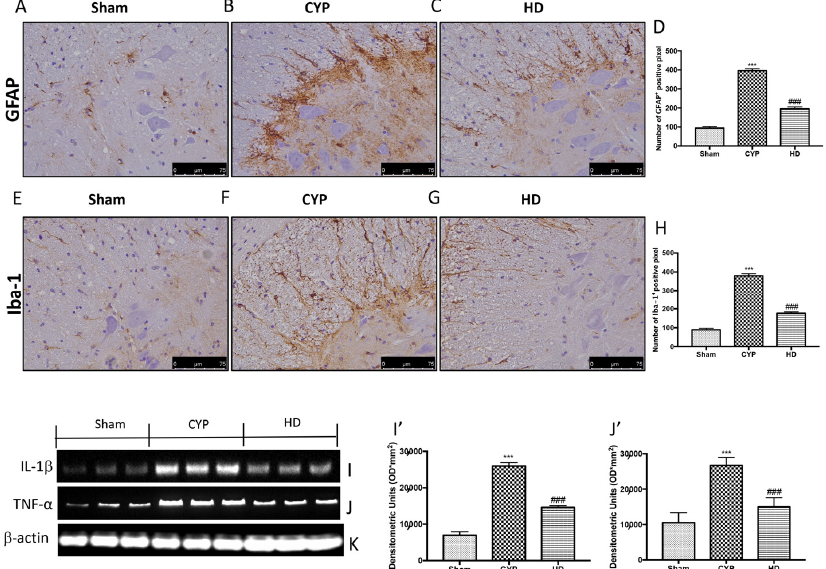
Figure 7. Effect of HD on neuroinflammation and on the release of proinflammatory cytokines in the spinal cord after repeated CYP injections. Immunohistochemical analysis showed a significant increase in glial fibrillary acidic protein (GFAP)-positive cells ( B , D ) and Iba-1-positive cells ( F , H ), compared to Sham mice ( A , D for GFAP and E , H for Iba-1). Mice treated with HD revealed a decrease in the expression of GFAP ( C , D ) and Iba-1 ( G , H ). Data are expressed as the number of GFAP- and Iba-1-positive pixels and are the means ± SEM of five animals for each group. Western blot analysis showed that IL-1 β expression was significantly increased in the CYP group, while treatment with HD decreased the expression of IL-1 β ( I , I’ ). TNF- α expression was significantly increased in the CYP group, while treatment with HD decreased the ex- pression of TNF- α ( J , J’ ). Protein lysates were also incubated with a β -actin antibody ( K ) in order to verify that all samples had been loaded in equal quantities. Values are means ± SD of five animals for each group; *** p < 0.001 vs. Sham; ### p < 0.001 vs. CYP.